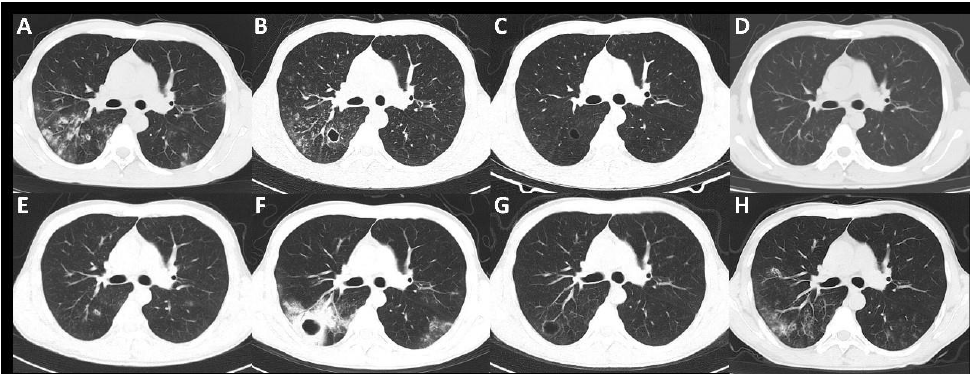
Figure 2. Changes in chest CT imaging during treatment. ( A ) In October 2018, before anti-tuberculosis treatment, patchy shadows were seen in the posterior segment of the right upper lobe and the dorsal segment of the left lower lobe. ( B ) In December 2018, after 3 months of anti-tuberculosis treatment. A new cavity appeared in the lower lobe of the right lung. ( C ) In February 2019, after receiving levofloxacin, glucocorticoids and cyclophosphamide for one month, the multiple patchy shadows in both lungs were alleviated, and the right pulmonary cavity was reduced, with a thinner wall. ( D ) In April 2019, after receiving glucocorticoids and cyclophosphamide for 3 months, there were more patchy shadows in both lungs, and the right pulmonary cavity was smaller, but the cavity wall was thicker. ( E ) In May 2019, after receiving ceftazidime treatment, the right lung cavity shrank. ( F ) In November 2019, after receiving glucocorticoid and azathioprine therapy for 4 months, new-onset patchy consolidation in both lungs was observed. A thick-walled cavity appeared in the right lower lung. ( G ) In November 2019, after receiving meropenem, cefepime and moxifloxacin treatment, the lesions in both lungs were significantly reduced, and the cavity wall of the right lower lobe became thinner. ( H ), In March 2021, after receiving prednisone, azathioprine and mycophenolate mofetil,